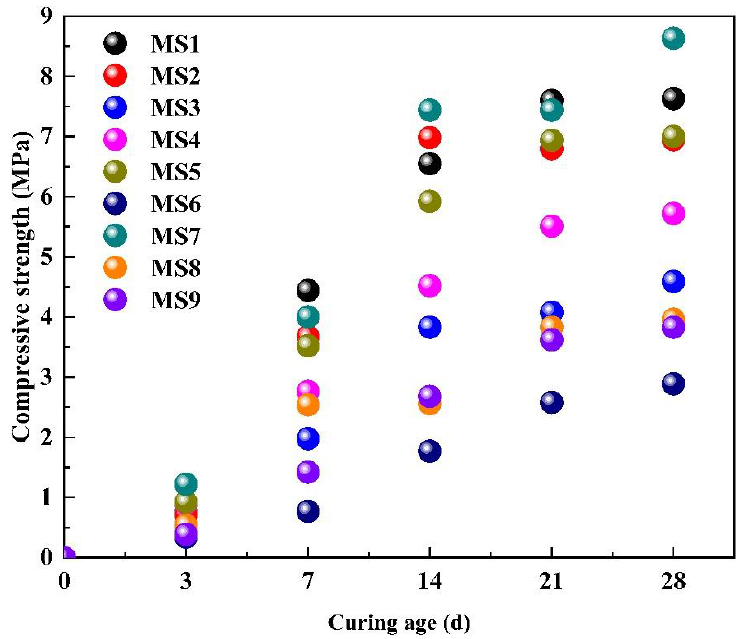
Figure 1. Compressive strength of solidified sludge samples.